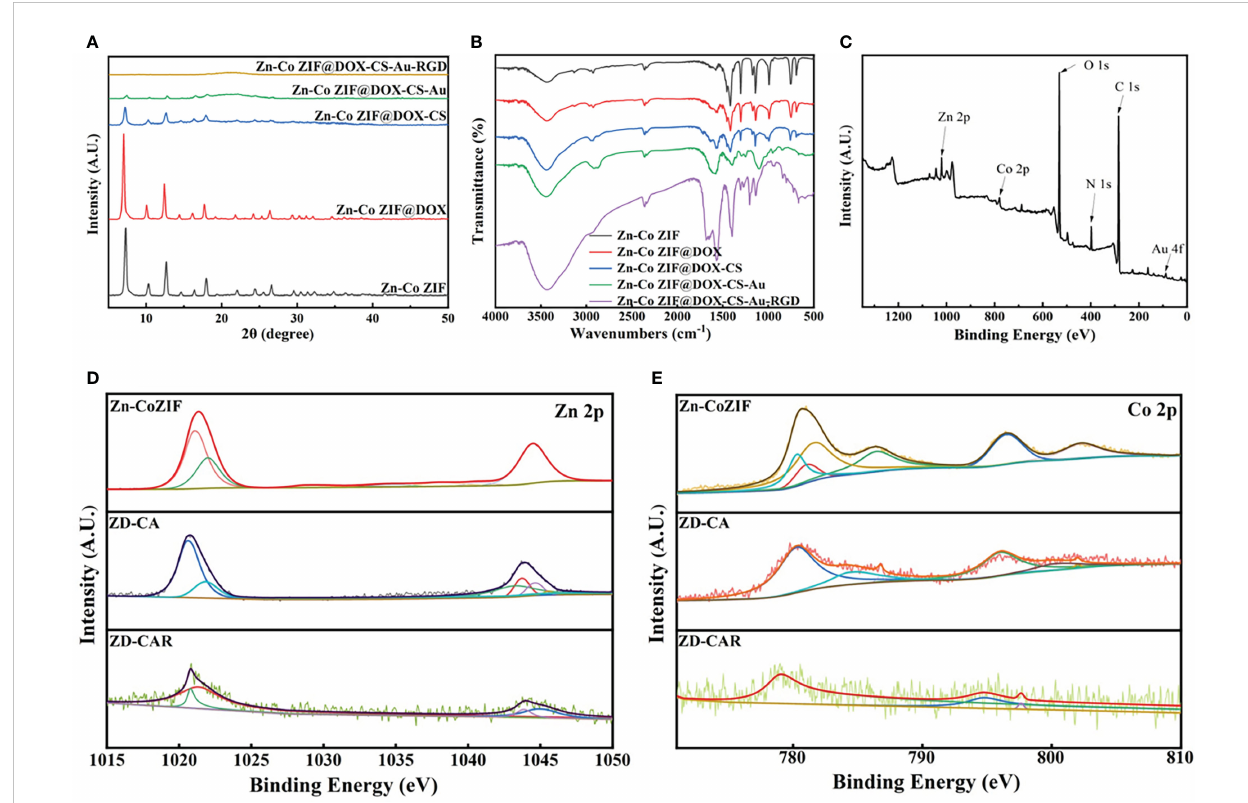
FIGURE 2 (A) XRD of Zn-Co ZIF, ZD, ZD-C, ZD-CA, ZD-CAR. (B) Infrared transmittance of Zn-Co ZIF, ZD, ZD-C, ZD-CA, ZD-CAR. (C) XPS of ZD-CAR. (D) XPS of Zn in every product and (E) XPS of Co in every